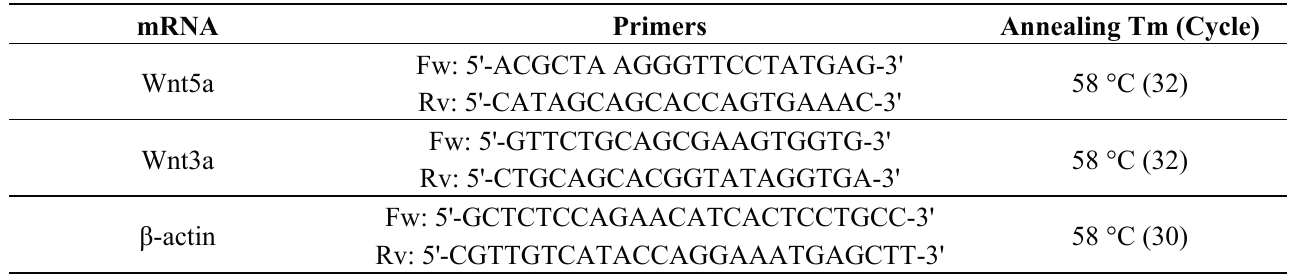
Table 2. Primer design for RT-PCR